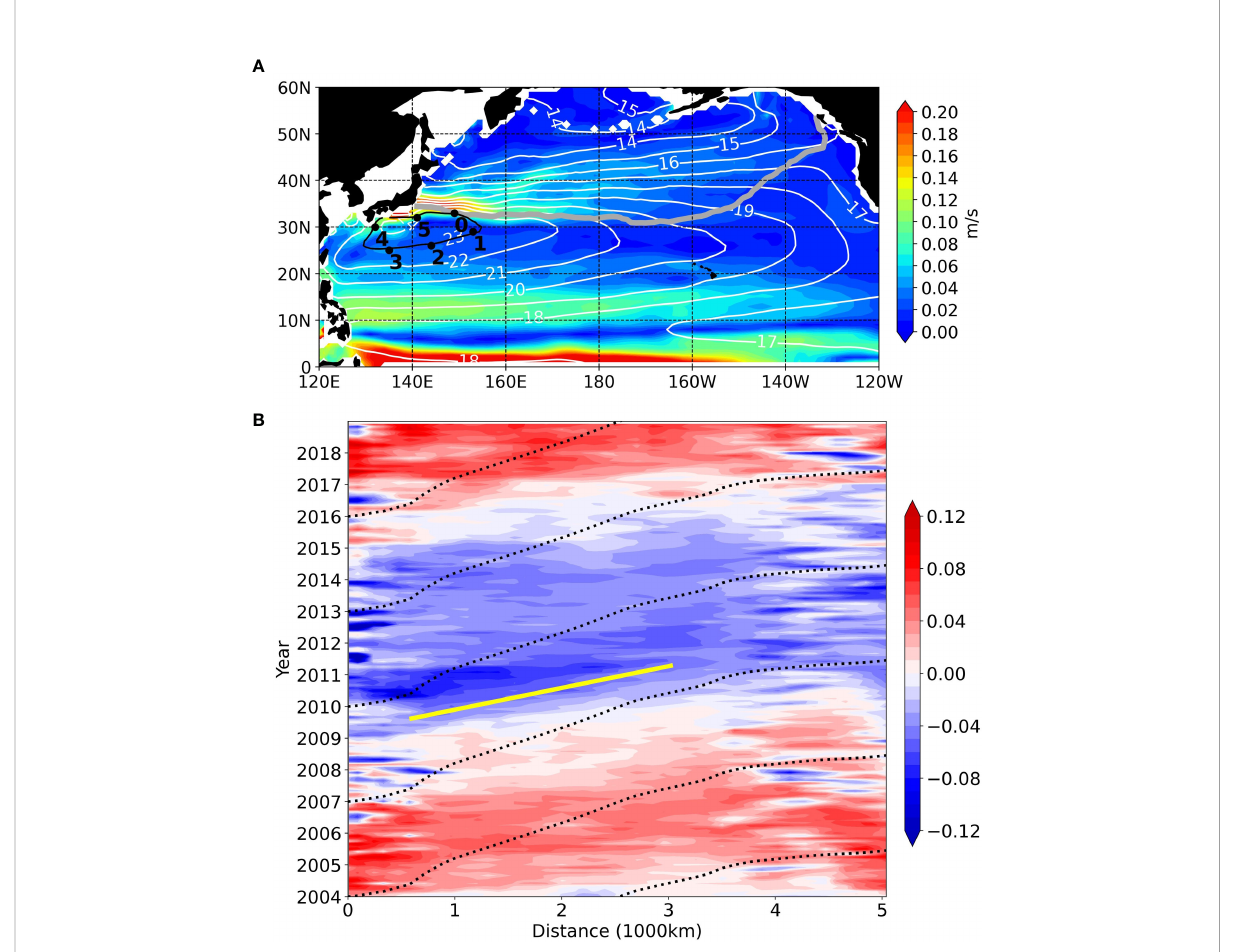
FIGURE 11 Same as in Figure 10 but on g = 25.3 surface along a 22.5 stream funtion isopleth. The yellow line indicates representative propagation speed of the anomalies, which is 0.02 m/s and 0.12 m/s